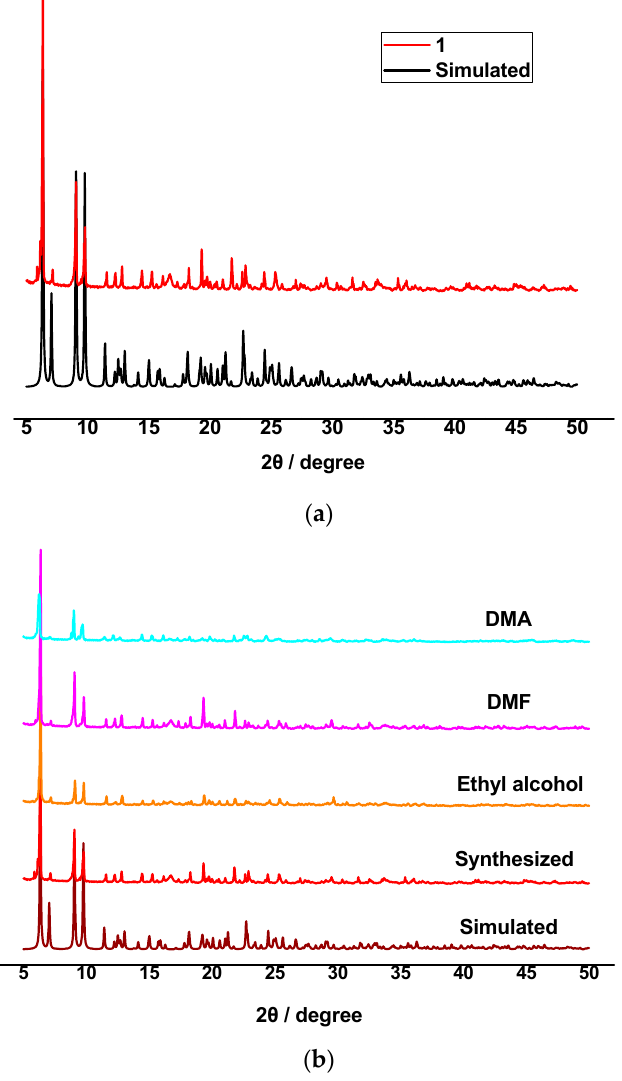
Figure 2. ( a ) PXRD patterns of 1 ; ( b ) PXRD patterns of 1 soaked in different solutions for 24 h. FT-IR spectrum of 1 in the range of 4000–400 cm − 1 was measured (Figure S1, Supplementary Materials). The strong and wide peak close to 3412 cm − 1 can be ascribed to the presence of N–H stretching vibration. The strong peaks of carboxyl groups appear in the region of 1648–1584 cm − 1 (antisymmetric stretching vibrations) and 1384–1420 cm − 1 (symmetric stretching vibrations) [45–47]. No FT-IR peaks around 1700 cm − 1 also demonstrated complete deprotonation of carboxyl groups [48–52]. The peaks located at 1499 cm − 1 are from the tetrazole group. The band located at 1296 cm − 1 can be ascribed to the